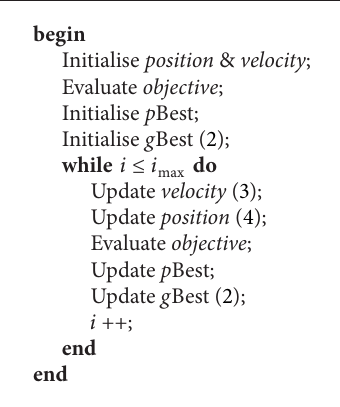
Algorithm 1: The PSO